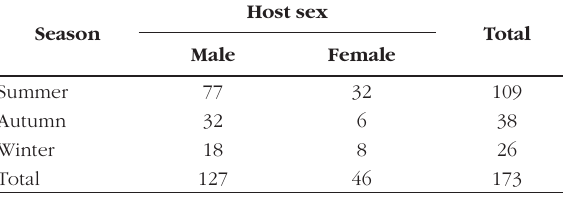
Table I. – Structure of the sampled host population of T. zilli by season of capture and host